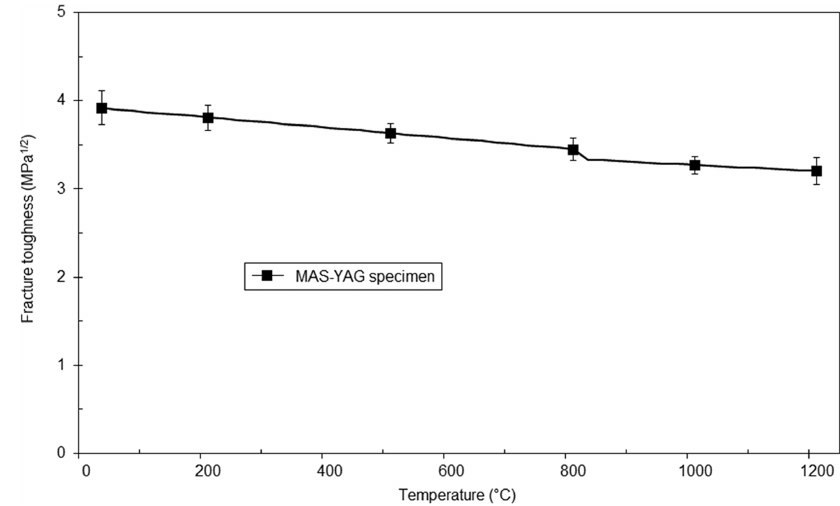
Figure 6: The fracture toughness of MgAl 2 O 4 -Y 3 Al 5 O 12 crystal as a function of